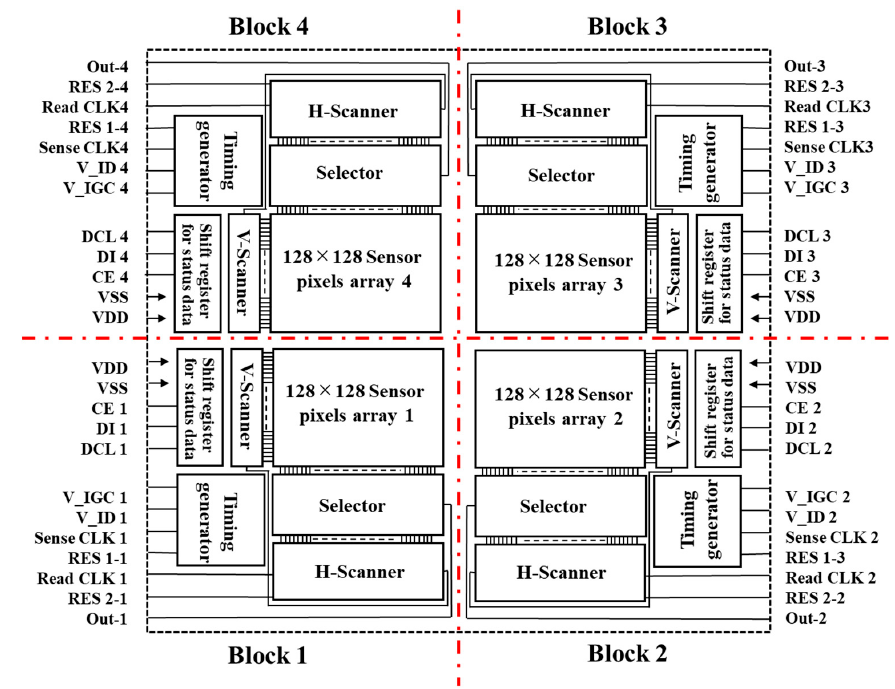
Figure 2. Block design for the present multi-ion sensor.